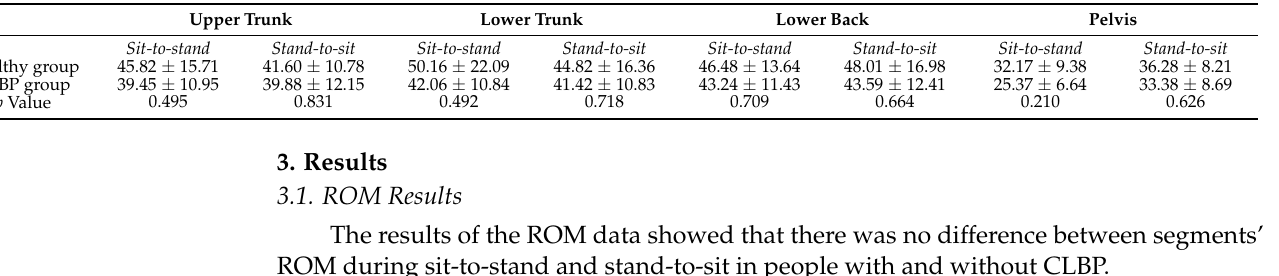
Table 2. The results of ROM data in degrees (Ave ±